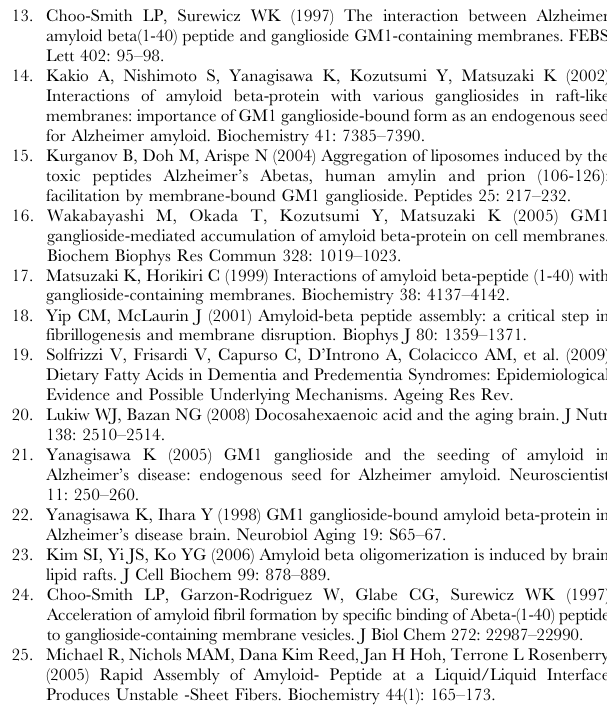
Figure S1 Far-UV CD spectra of 25 m M A b 42 incubations with NEFAs at concentrations well below the respective CMCs; 20 mM C9 (A), 10 mM C10 (B), 2 mM C11 (C) and 2 mM C12 (D). To data points are shown; initial 0 h point and the final 240 h point. Data were normalized as mentioned in Materials and Methods. (TIF) Figure S2 Guanidine denaturation of hGRN-A incubated with NEFAs as a negative control. Buffered (20 mM TrisHCl, 50 mM NaCl, pH 8.0) hGRN-A (15 m M) was incubated with 5 ( # ) or 20 mM C12 ( m ) at 37 C.After 48 h, aliquots of the sample was subjected to GnHCl titration (using 6 M GnHCl as stock) that was monitored by tryptophan intrinsic fluorescence ( l ex =280 nm; l em = 340 nm). Data were normalized and fit using the same calculations as mentioned in Materials and Methods. (TIF) Figure S3 Incubation of 5 & 20 mM C12 with varying concentrations of A b 42 ; lane (1–4) 5 mM C12 with 12.5, 25, 50, 75 m M A b 42 respectively ; lane (5–8) 20 mM C12 with 12.5, 25, 50, 75 m M A b 42 respectively.